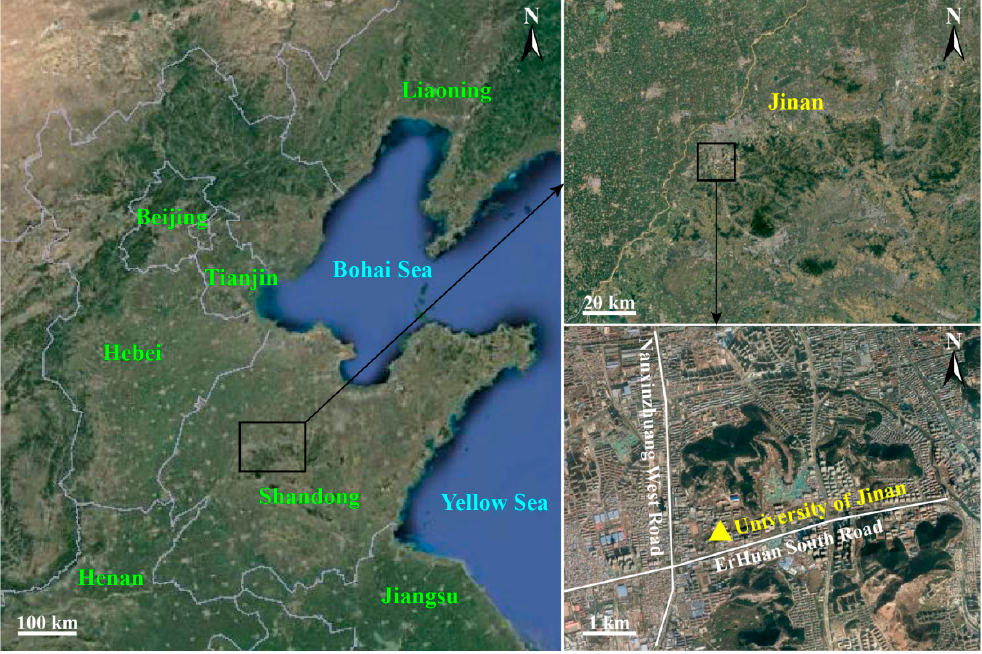
Figure 1. Location of sampling site.